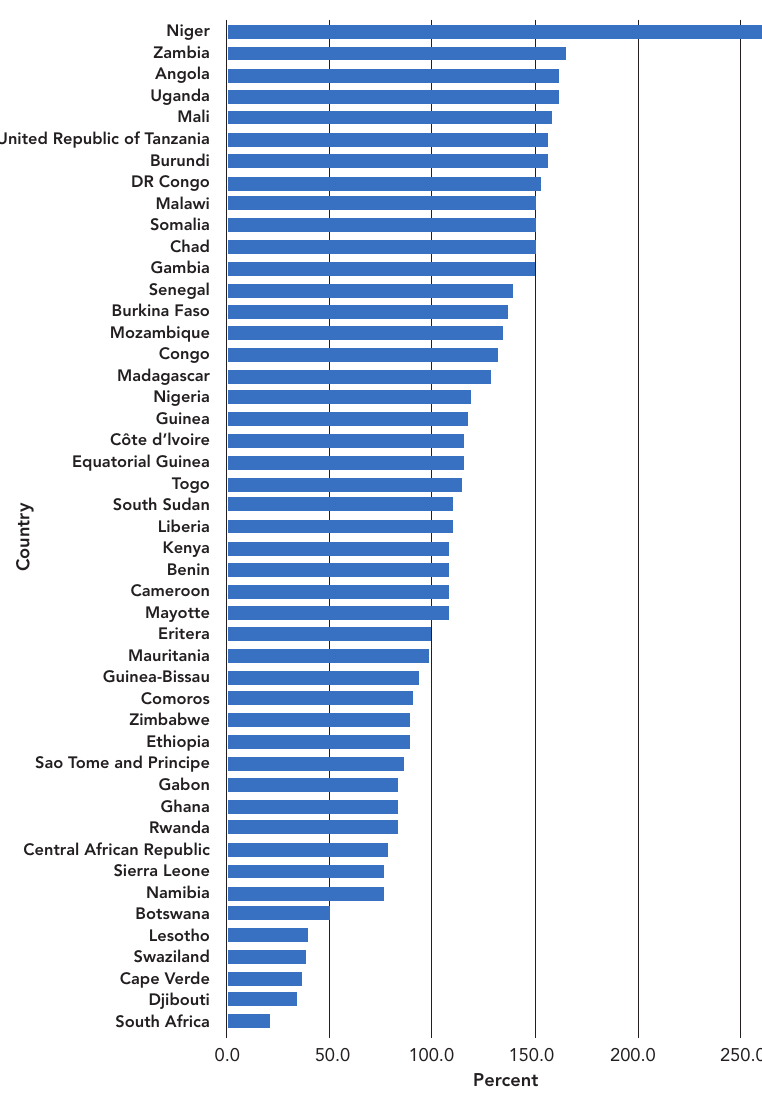
SOURCE: UNITED NATIONS.2015 WORLD POPULATION PROSPECTS: THE 2015